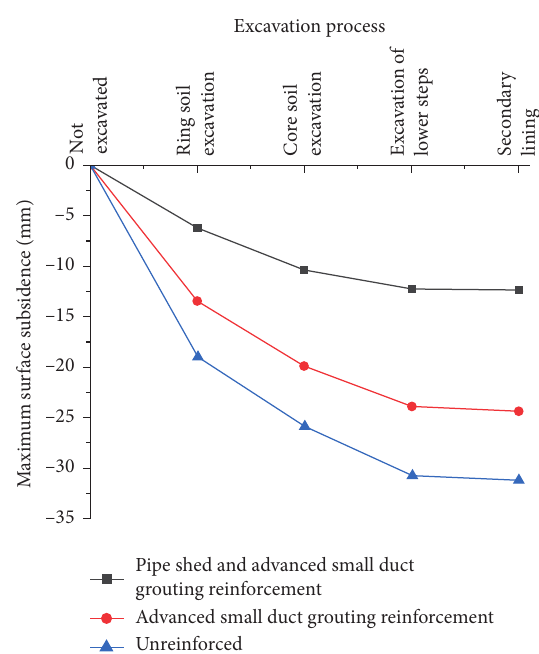
Figure 9: Comparison of maximum accumulated surface settlement.